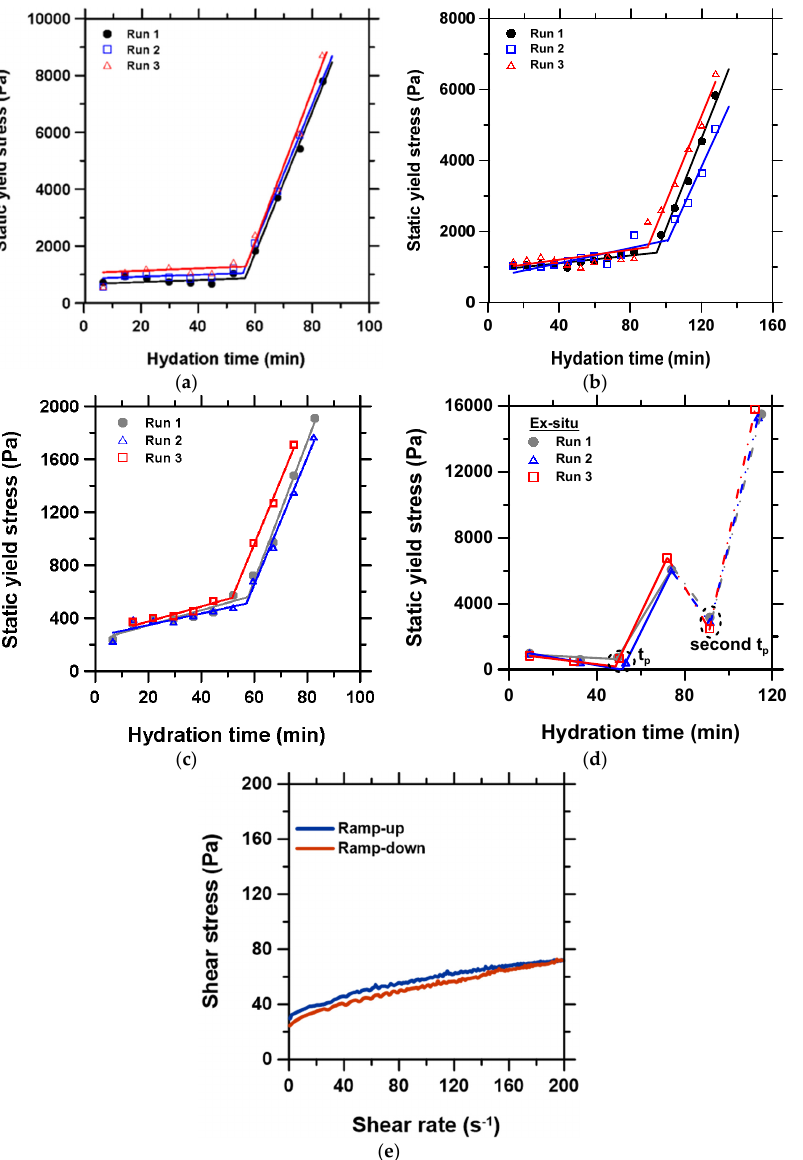
Figure 7. Time-dependent static yield stress evolution obtained with: ( a ) parallel plate geometry gap of 700 µm, ( b ) parallel plate geometry gap of 1000 µm, ( c ) vane rotor and cylinder cup geometry, ( d ) parallel plate geometry gap of 700 µm accompanied with ex situ re-mixing of pastes at 250 rpm prior to loading sample for each subsequent interval measurement, and ( e ) representative shear stress—shear rate curve for the ramp-up and -down between 0 and 200 s − 1 , showing a minimal hysteresis loop below the shear rate of 160 s − 1 .